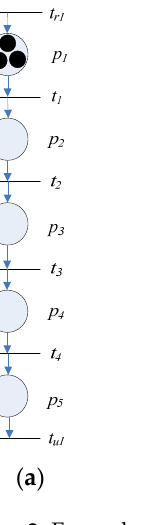
∈ J = { 1,2 } : ( a ) GJ j , where j 1 ; ( b ) GJ 2